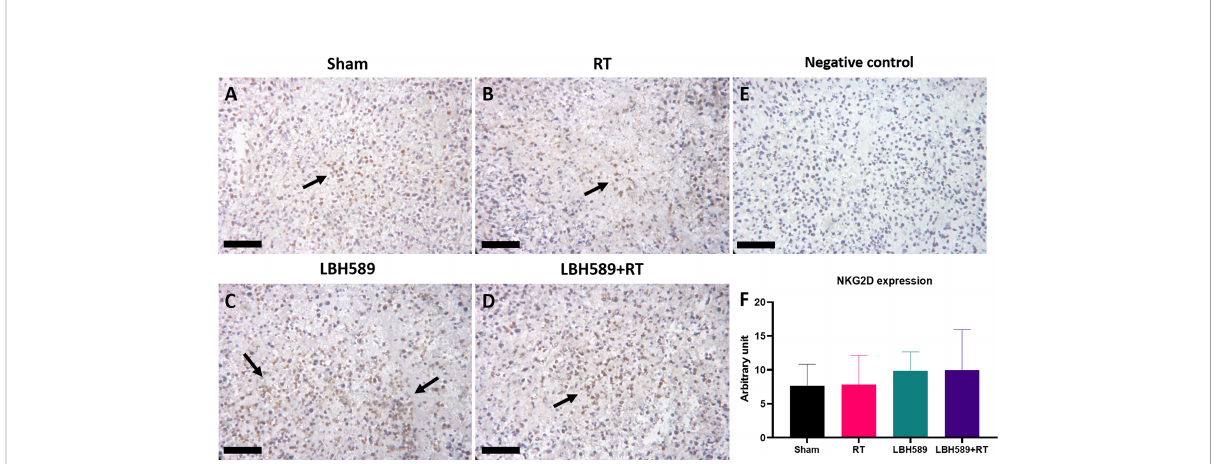
FIGURE 6 Immunohistochemistry (IHC) staining of NKG2D expression in tumor tissues of (A) sham, (B) radiotherapy (RT), (C) pan-HDAC inhibitor (LBH589), (D) combined treatment groups, as well as (E) negative control and (F) quanti fi cation data. The black arrows indicate positive cells. Black bar = 25 m m. Error bars indicate